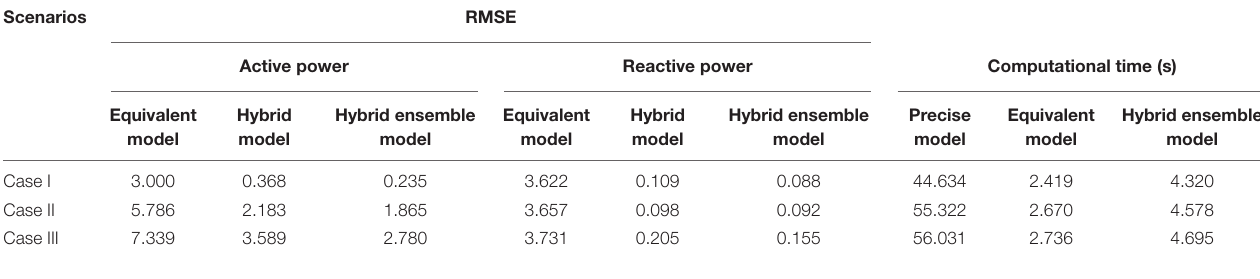
TABLE 4 | Computational errors (RMSE) and computational time of different